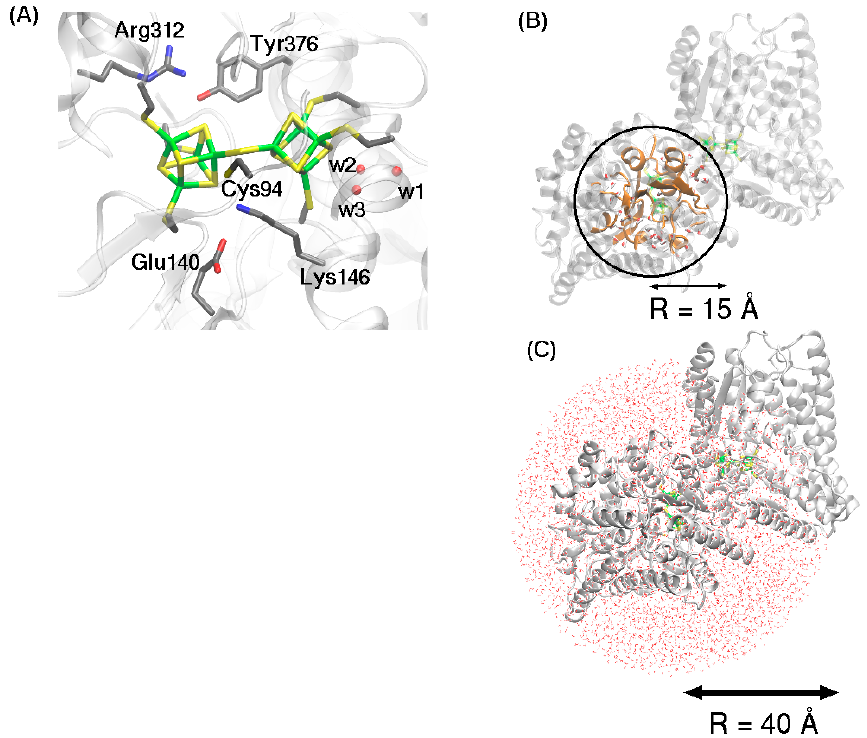
Figure 9. The QM/MM setup of the system consists of a three-tiered approach. ( A ) The model of the double ‐ cubane cluster of DCCP Ch was constructed from the structure file 6ENO.pdb (1.63 Å) [1], coordinated to Cys75, Cys113, Cys143, Cys308, Cys340 and Cys373. A ‐ cluster is linked to B ‐ cluster via the μ 2 ‐ S ligand (S9). ( B ) The second layer of the model includes all protein and water atoms within a radius of 15 Å from the iron atom Fe8 located on the A ‐ cluster. ( C ) The third layer includes all remaining protein, solvent, and salt ions within a 40 Å radius of Fe8; these atoms were held fixed during all geometry optimizations. Sulphur atoms are colored yellow; iron atoms are green; carbon atoms are cyan, and hydrogen atoms are white.